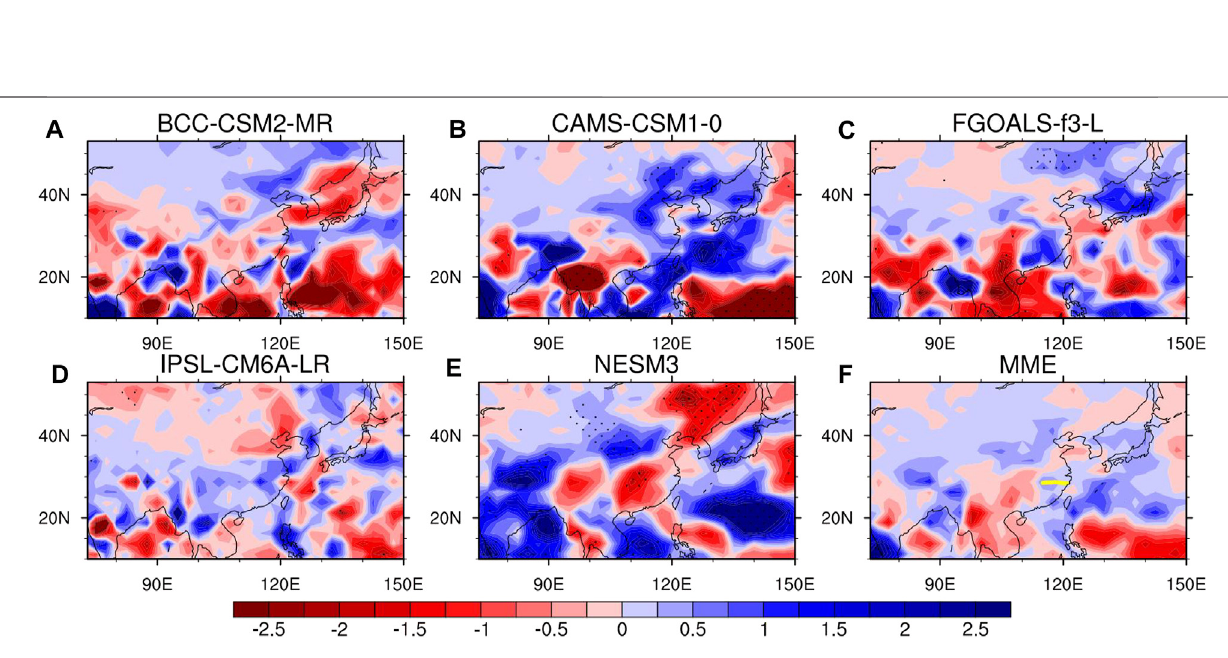
Frontiers in Earth Science |